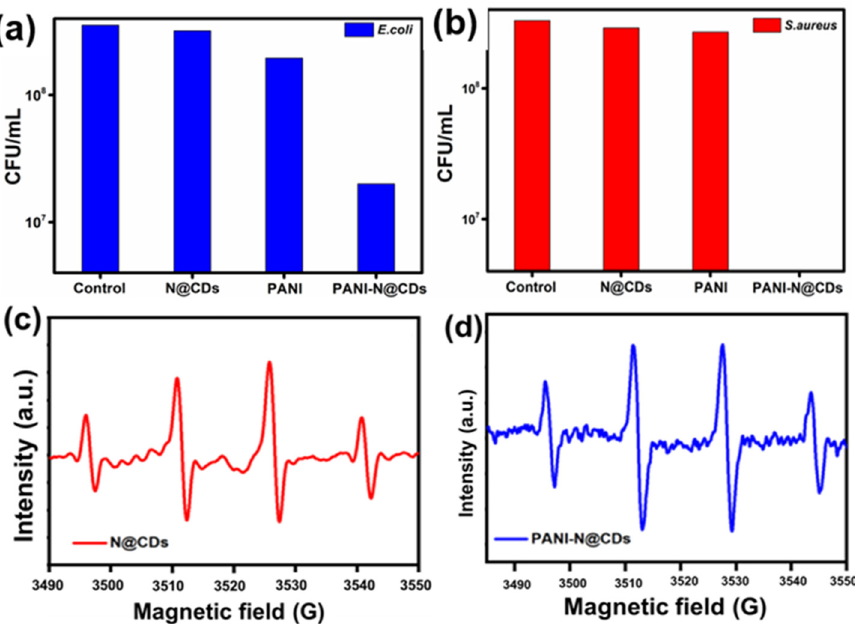
Figure 7. Antibacterial treatment of N@CDs, PANI, and PANI-N@CDs against ( a ) E. coli and ( b ) S. aureus ; ( c , d ) EPR spectra for N@CDs and PANI-N@CDs. ( b ) S. aureus ; ( c , d ) EPR spectra for N@CDs and